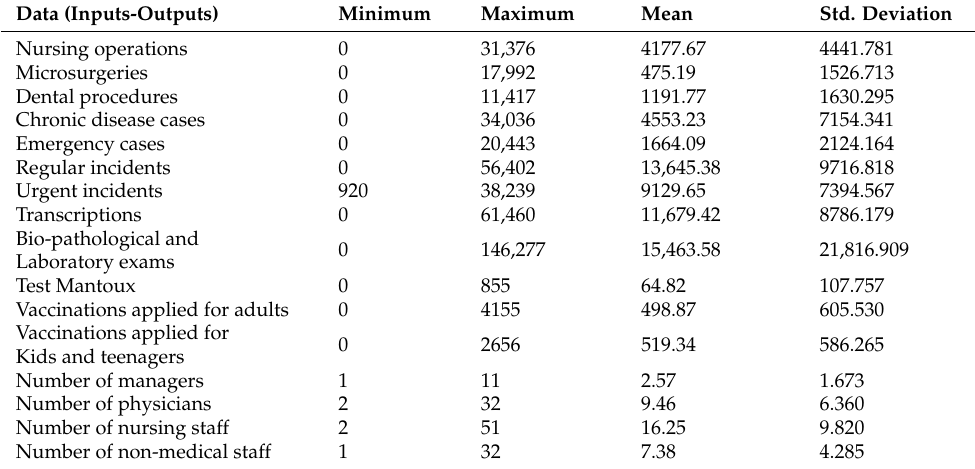
Table 2. Descriptive statistics.